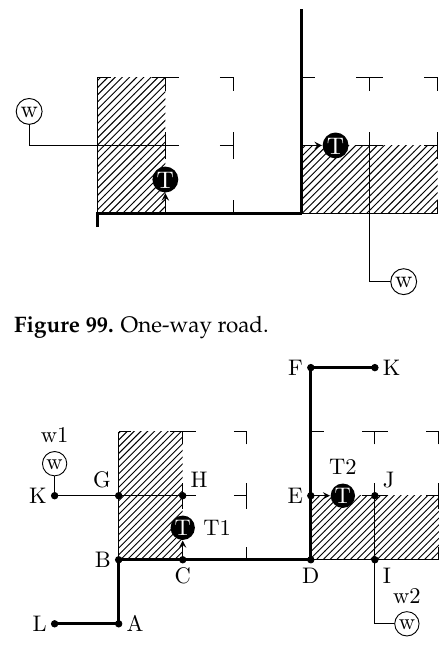
Figure 100. One-way road with